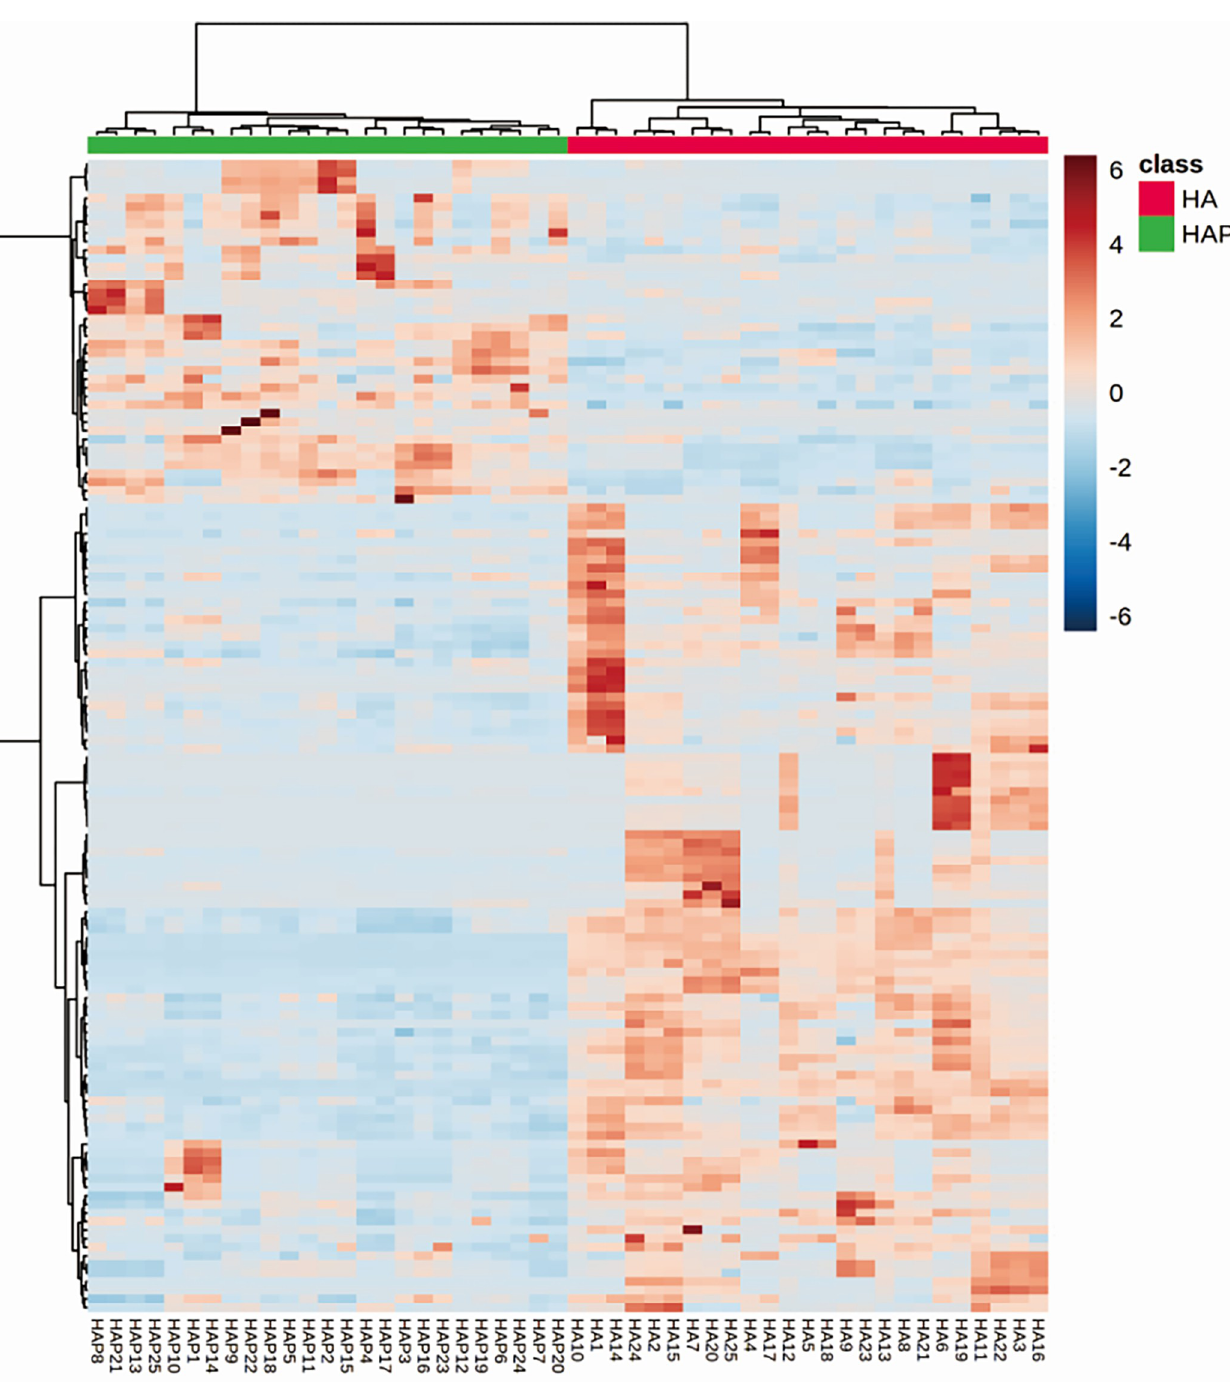
2-arachidonoyl glycerol upregulated when exposed to hypoxic environment and when back to the low altitude area the content of most acylcarnitines decreased compared with the high alti- tude plateau. In addition, acylcarnitines increased when exposed to hypoxia and then decreased after back to the low altitude area. That hypoxic exposure causes elevated carnitine